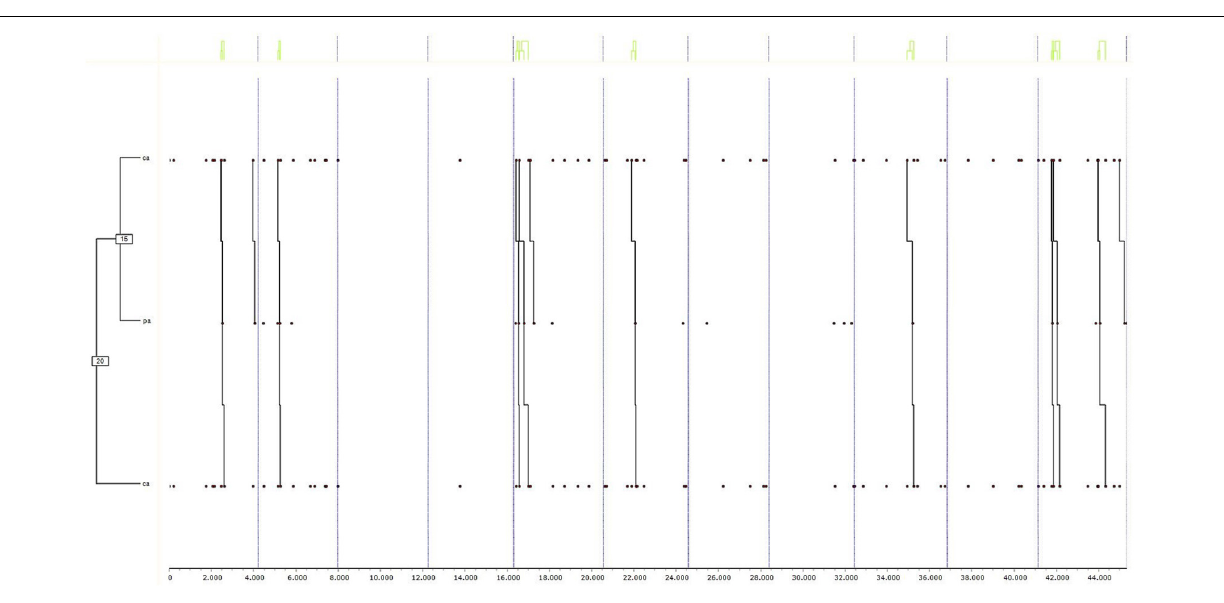
FIGURE 3 | Dendogram obtained from THEME belonging to group “1” exclusively in boys. The decisional categories of the mixed registration system ( Table 1 ) were used for searching for